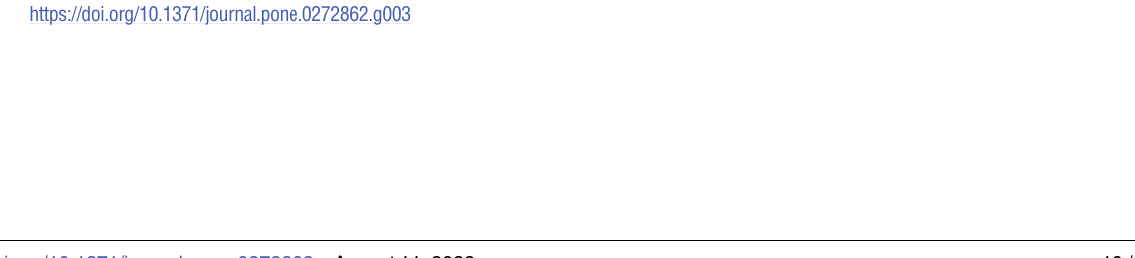
PLOS ONE | https://doi.org/10.1371/journal.pone.0272862 August 11, 2022 10 /